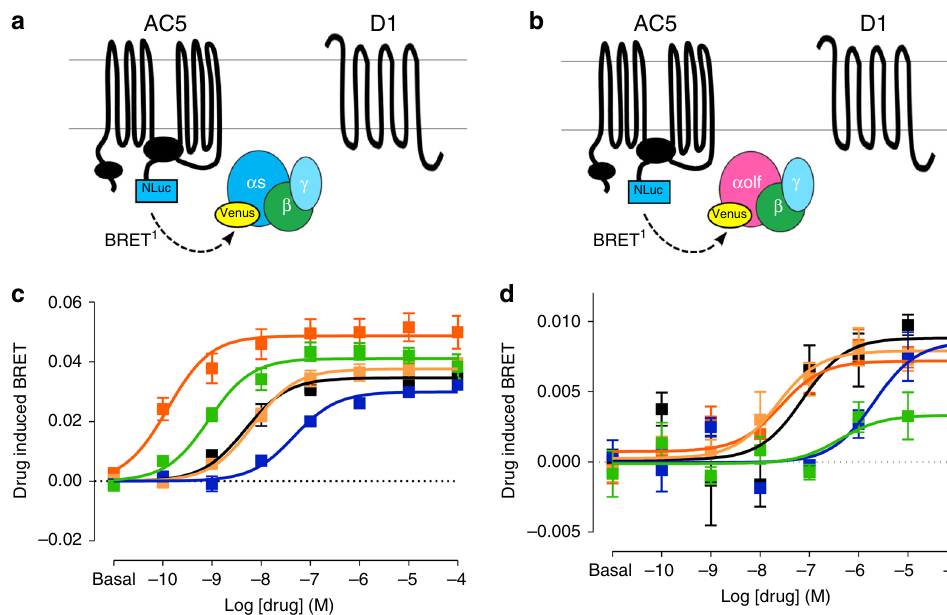
Fig. 3 a . Scheme for the drug-induced interaction BRET between AC5-Nluc and Gs-Venus. b Scheme for the drug-induced interaction BRET between AC5- Nluc and Golf-Venus. c Dose-response curves of drug-induced BRET between AC5-Nluc and Gs-Venus (black DA, blue norepinephrine, light orange SKF38393, dark orange SKF81297, green DHX, black open SCH23390+ 10 − 6 SKF81297). d Dose-response curves of drug-induced BRET between AC5- Nluc and Golf-Venus (same color scheme). The error bars represent